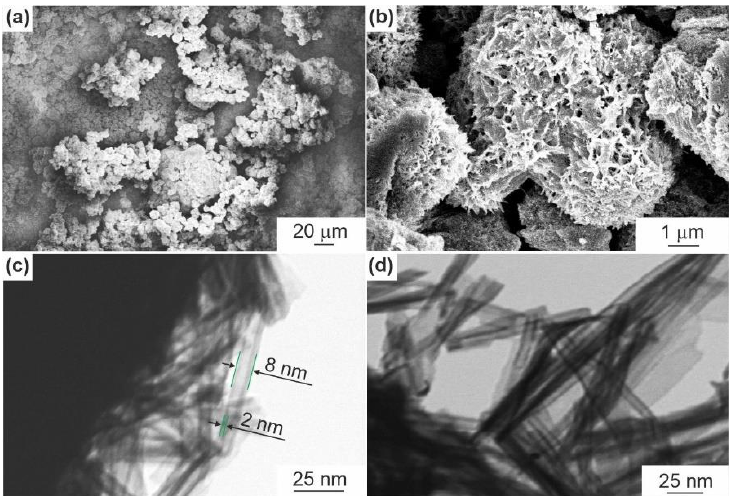
Figure 2. SEM-images show the microscale topography for NTO-120 sample at the magnifications of 300× ( a ) and 10,000× ( b ). STEM-imaging at the magnification of 700,000× reveals the structural hierarchy of NTO-120 ( c ) and NTO-350 ( d ) products.